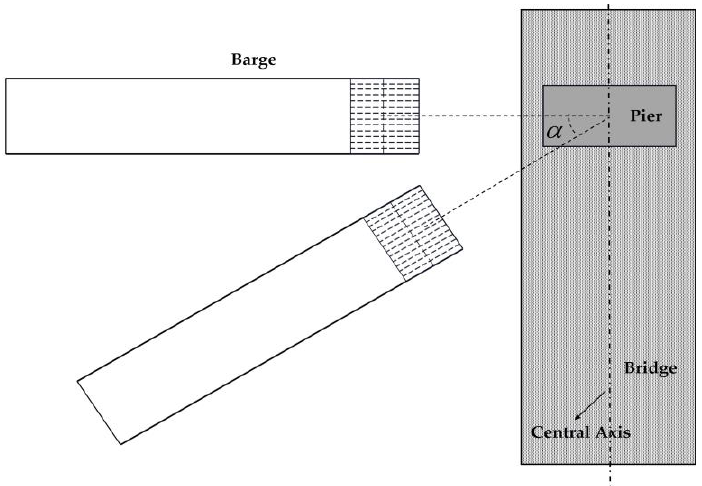
Figure 14. Schematic diagram of barge-impact angle α .